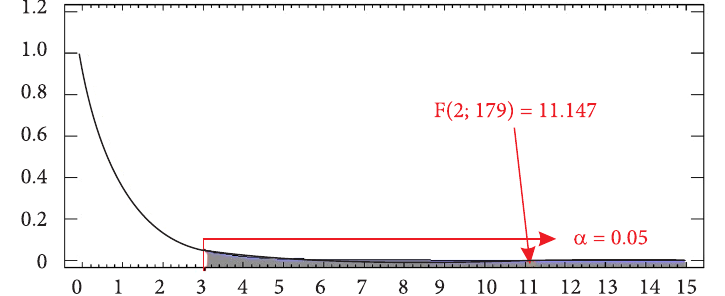
Figure 2. Verification of the model (source: own